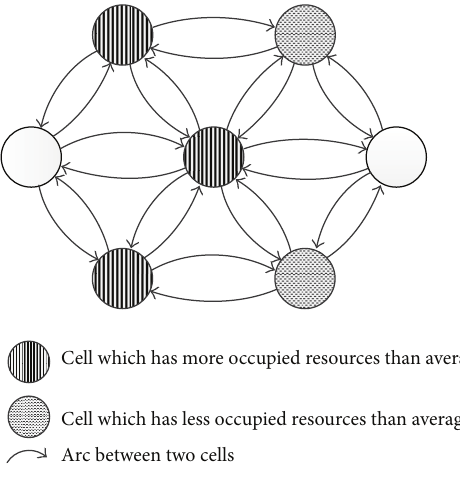
Figure 7: Seven nodes representing 7 cells. Figure 8: Arcs between the virtual source node and source nodes (sink nodes and the virtual sink